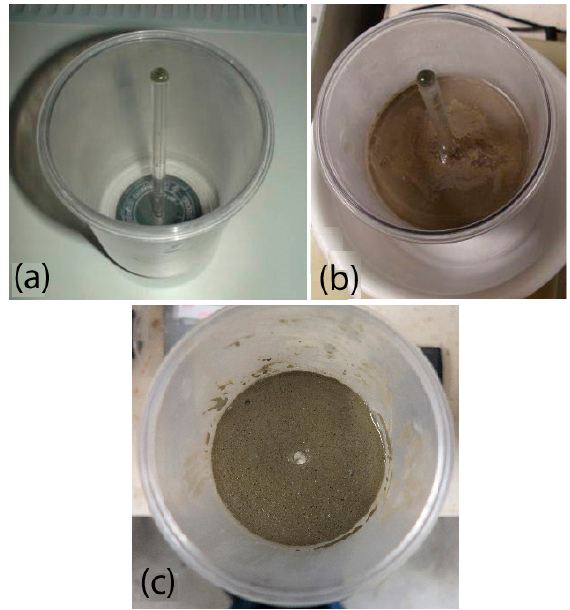
Figure 2. Specimen preparation: ( a ) empty test cell; ( b ) test cell with grout mixture; ( c ) specimen ready for testing.